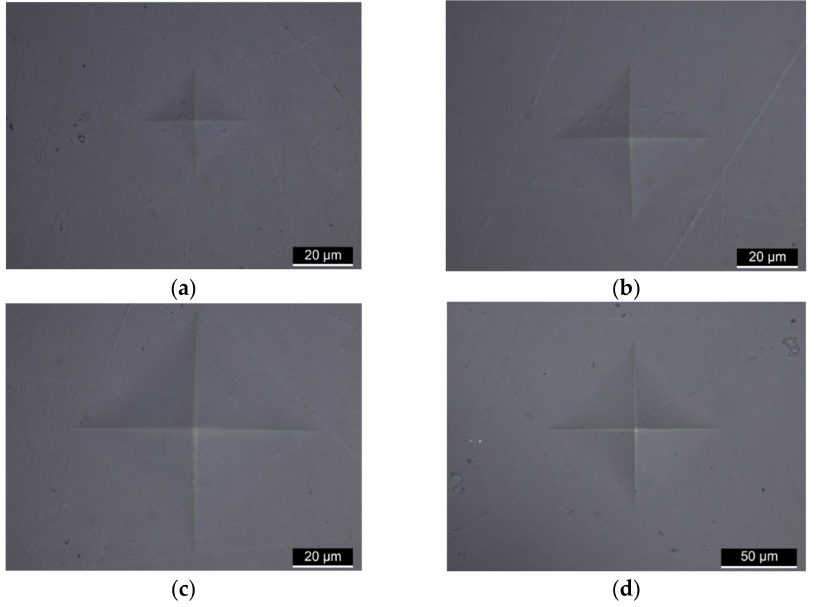
Figure 3. Optical microscope images of the ( a ) 5 g, ( b ) 10 g, ( c ) 25 g and ( d ) 50 g indents ( a – c ) taken at